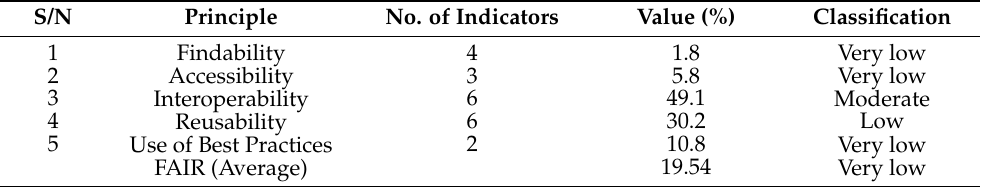
Table 11. Summary of FAIR Principles for Disaster Management